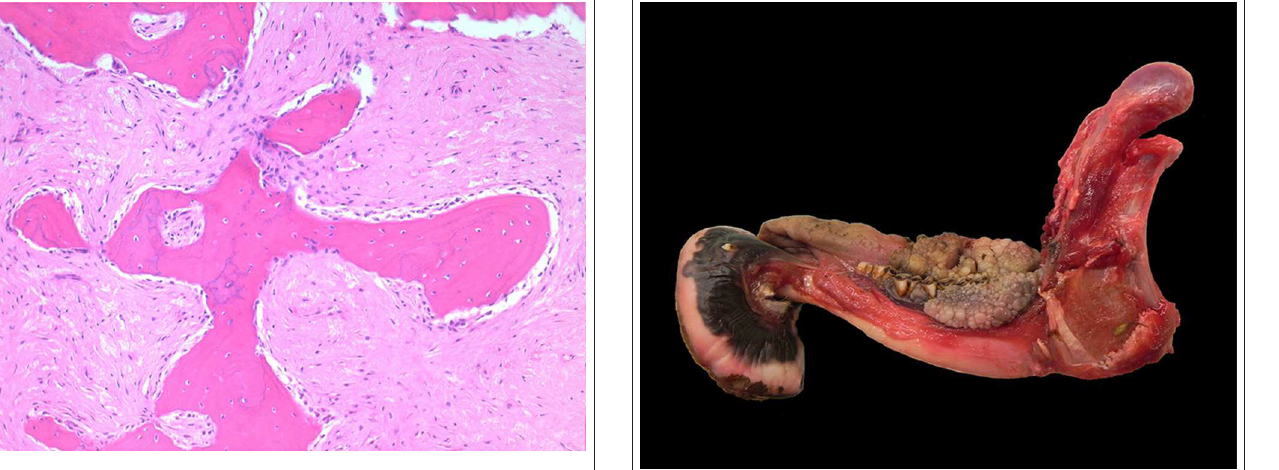
FIGURE 7 | Mandibular mass, roe deer; embedding the bony spicules were streams and bundles of spindled cells supported by an abundant eosinophilic matrix; H&E stain.